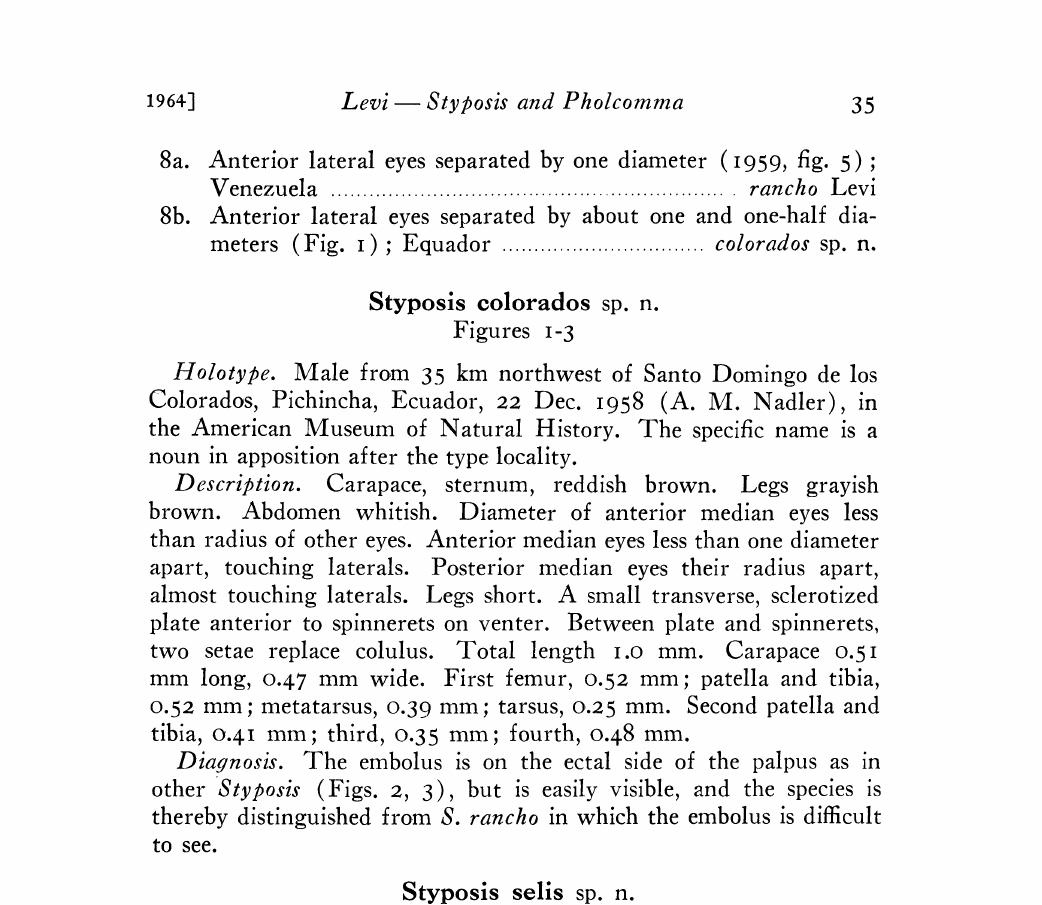
Figs. 1-3. Styposis colorados sp. n. 1. Male Carapace. 2. Left palpus, ventral view. 3. Left palpus, ectal view. Figs. 4-9. S. sells sp. n. 4. Palpus. 5. Male. 6. Female genitalia, dorsal view. 7. Epigynum. 8. Female. 9. Left female chelicera, posterior view. Figs. 10-12. S. clausis Levi. 10. Left Female chelicera, posterior view. 11. Palpus. 12. Male. Figs. 13-14. S. rancho Levi. 13. Female genitalia, dorsal view. 14.